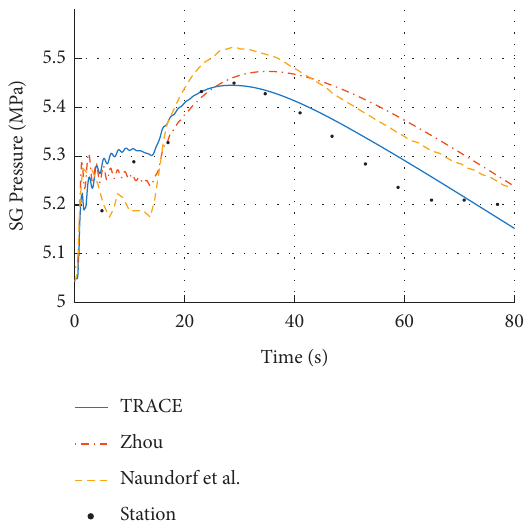
Figure 32: Steam generator pressures for the loss of flow